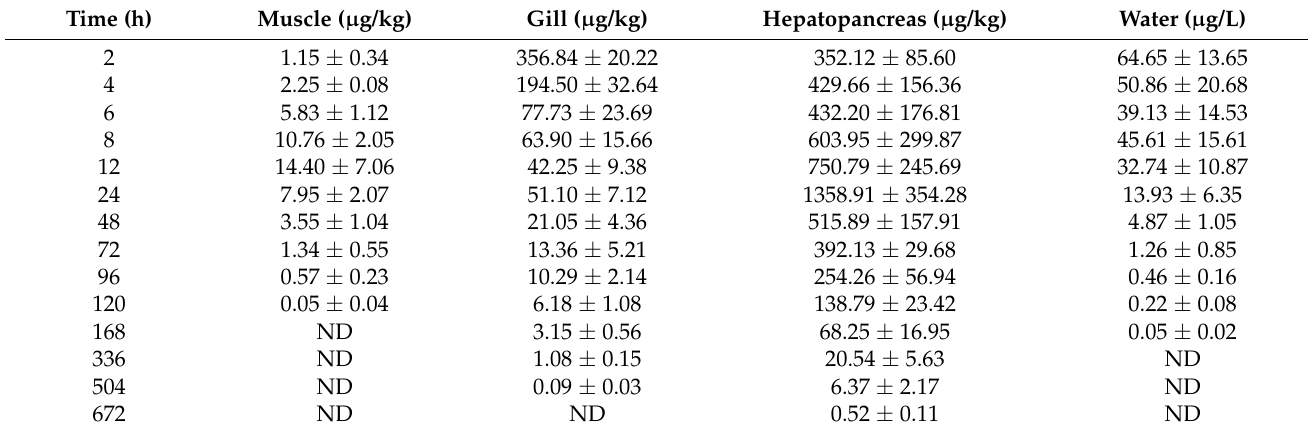
Table 5. Indoor exposure tests of pendimethalin added to tank water at 0.27